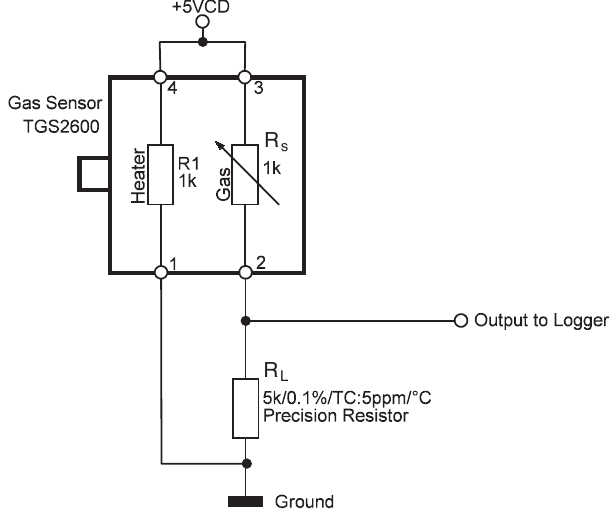
Fig. 2. Sensor configuration used in this study. The variable sensor resistance R s was measured between pins 2 and 3 and converted to a measurable voltage using an R L = 5k (cid:127) precision